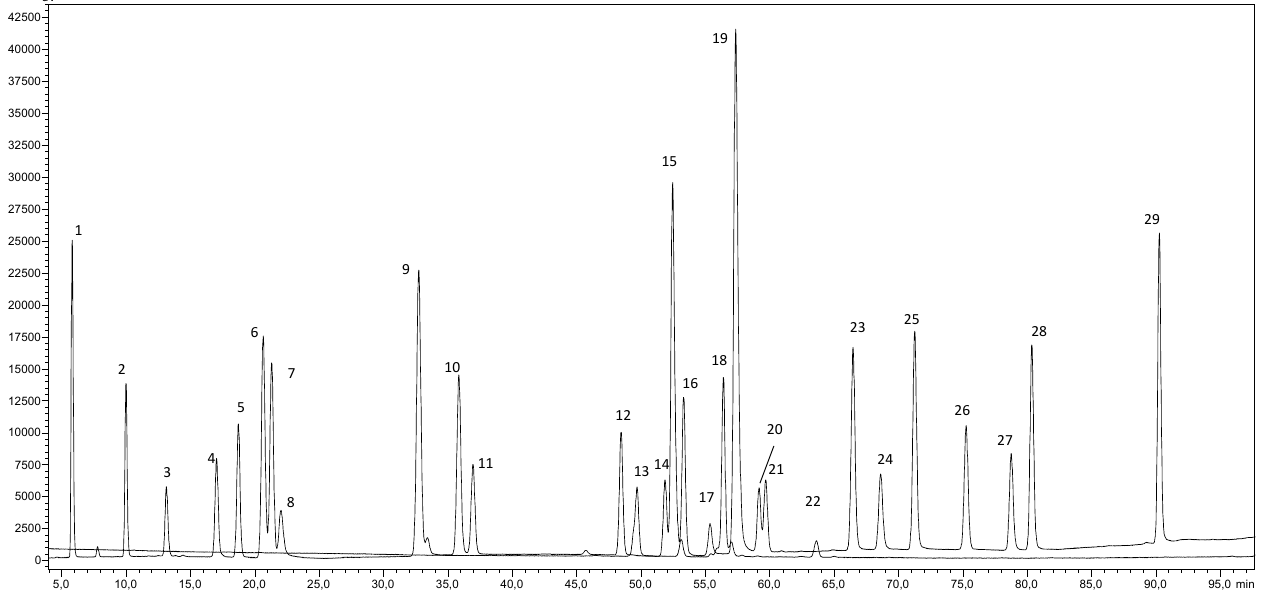
Figure 1. HPLC-DAD chromatogram monitored at 280 nm for a polyphenol standard mixture of 5 mg/L; peak identification: (1) gallic acid, (2) protocatechuic acid, (3) (+)-catechin, (4) chlorogenic acid, (5) vanillic acid, (6) caffeic acid, (7) syringic acid, (8) ( − )-epicatechin, (9) p -coumaric acid, (10) trans -ferulic acid, (11) sinapic acid, (12) naringin, (13) 3,5-di-caffeoylquinic acid, (14) quercetin-3- O -galactoside, (15) rutin, (16) phloridzin, (17) ellagic acid, (18) 3,4-di- O -caffeoylquinic acid; (19) myricetin, (20) cinnamic acid, (21) kaempferol-3- O -glucoside, (22) kaempferol-3- O -rutinoside, (23) naringenin, (24) quercetin, (25) phloretin, (26) tiliroside, (27) kaempferol, (28) apigenin and (29) chrysin. Table 2. Content of the individual polyphenols in vine-cane extract obtained at the optimal SWE conditions (250 °C, 33 min). Results are expressed as mean ± standard deviation (milligrams of compound/100g dw, n = 3).